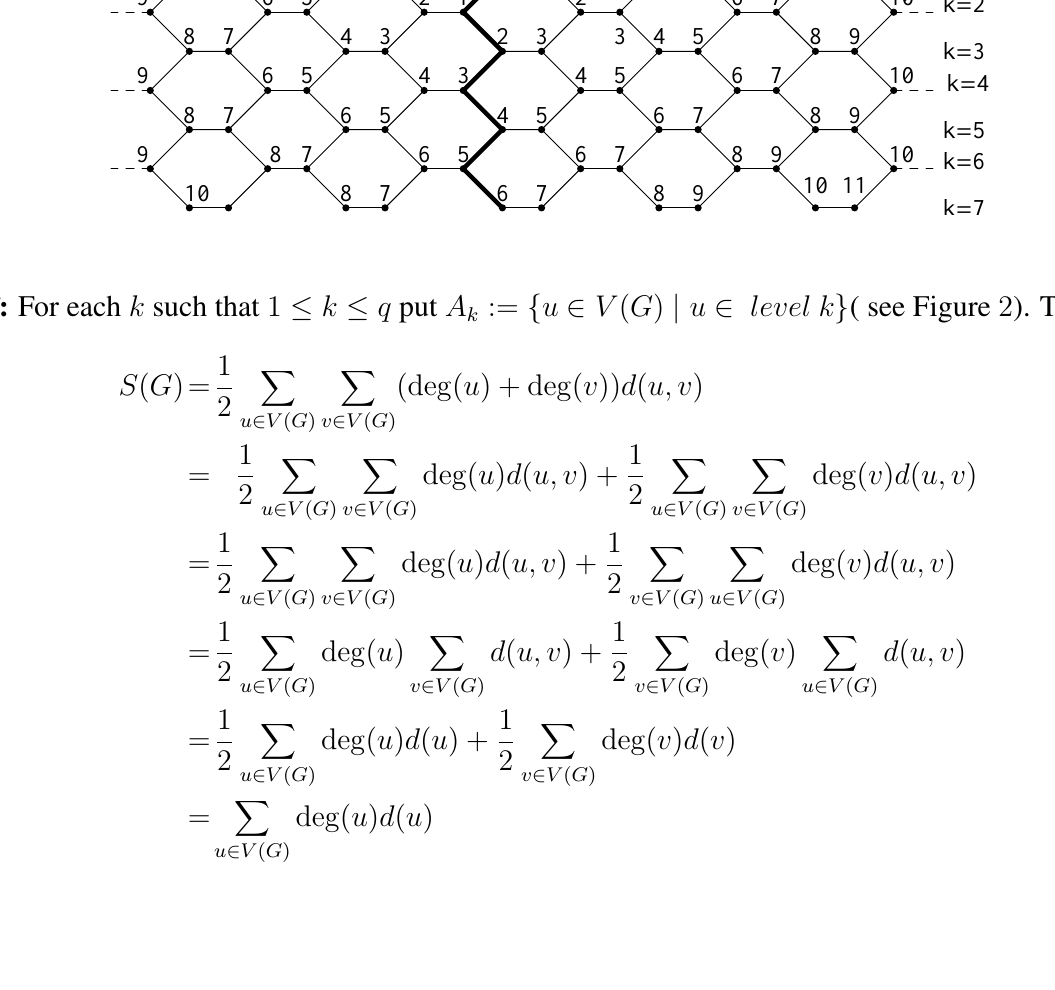
to all vertices of T UV C 01